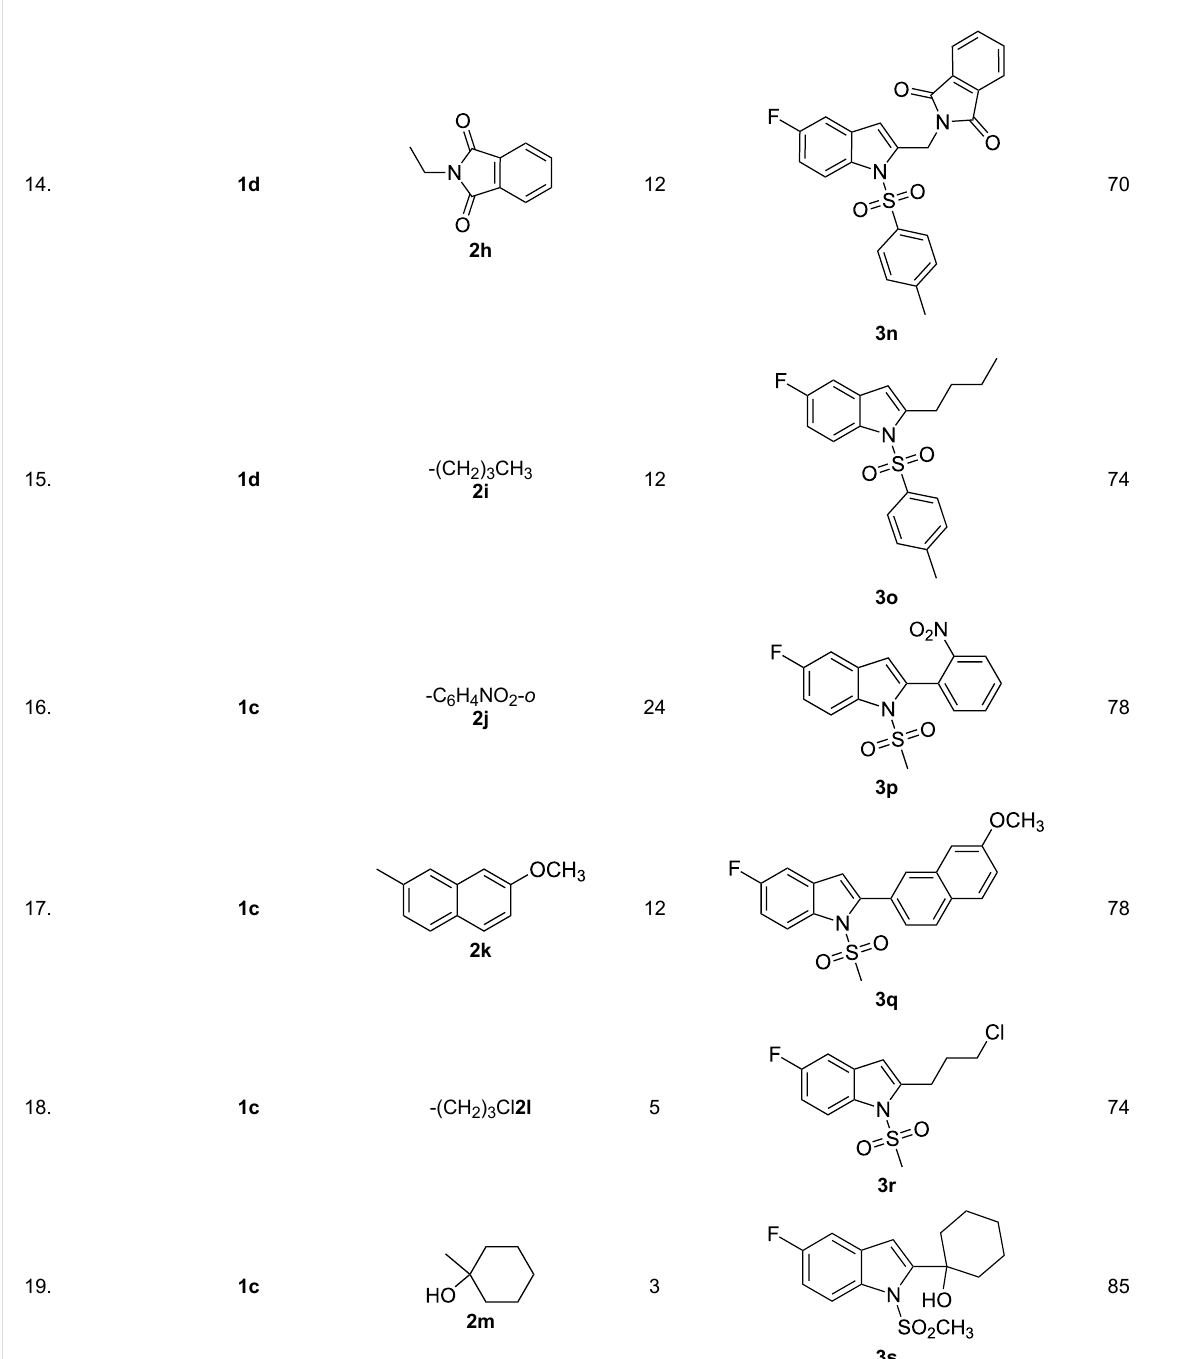
Table 1: Pd/C-Catalyzed synthesis of 2,5-disubstituted N -sulfonyl-indoles in aqueous media. a (continued)